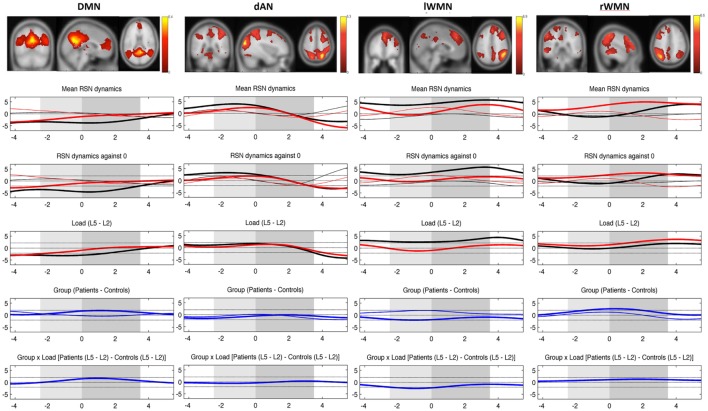
Mean evolution of TCNs over average trials. Upper plot shows the templates for each TCN from the study of Kottlow et al. with the three orthogonal slices through areas of maximum activation (only positive values; for detailed information about included regions, see Table S1 in Supplementary Material). Lower plots display the mean network evolutions over average trials for each load (thin line = load 2; thick line = load 5) and each group (black line = controls; red line = patients). Dashed lines indicate significance of the t-tests (two-sided, p = 0.05): (1) mean evolutions, (2) mean evolutions against 0, (3) load effect, (4) group effect (blue thin line = load 2; blue thick line = load 5), and (5) interaction of group by load. X-axis: time over trial [prestimulus: −4 to −2.5 s; stimulus (light gray block): −2.5 to 0 s; retention (dark gray block): 0–3.5 s; probe: 3.5–5.5 s], Y-axis: percent signal change of variance normalized, and z-transformed TCNs’ time courses.